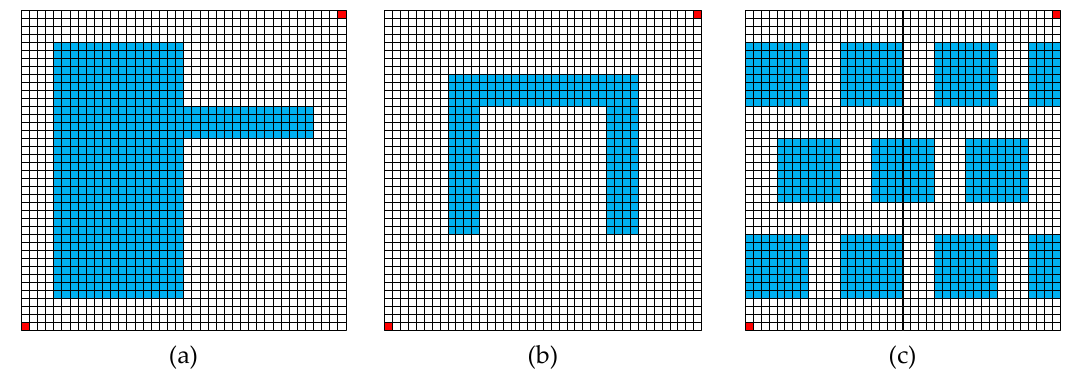
Figure 11. The experimental configuration of the 40 × 40 cells: ( a ) 40_1o; ( b ) 40_1n; and, ( c ) 40_11s.